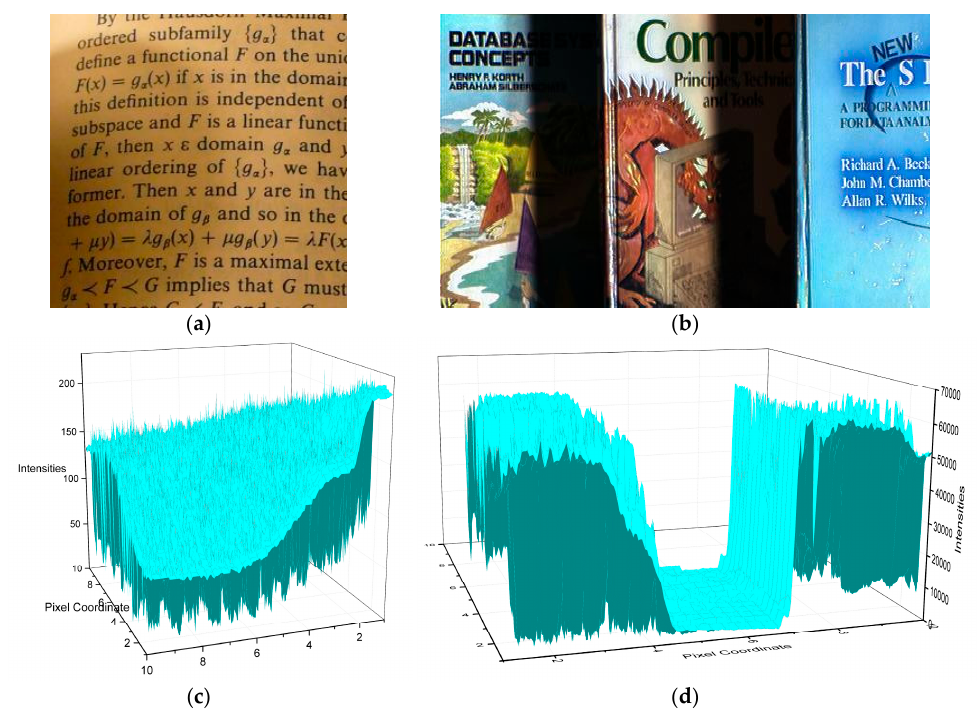
Figure 3. Images with different illumination and the corresponding surfaces: ( a ) text image; ( b ) book image; ( c ) surface of ( a ); ( d ) surface of ( b ).